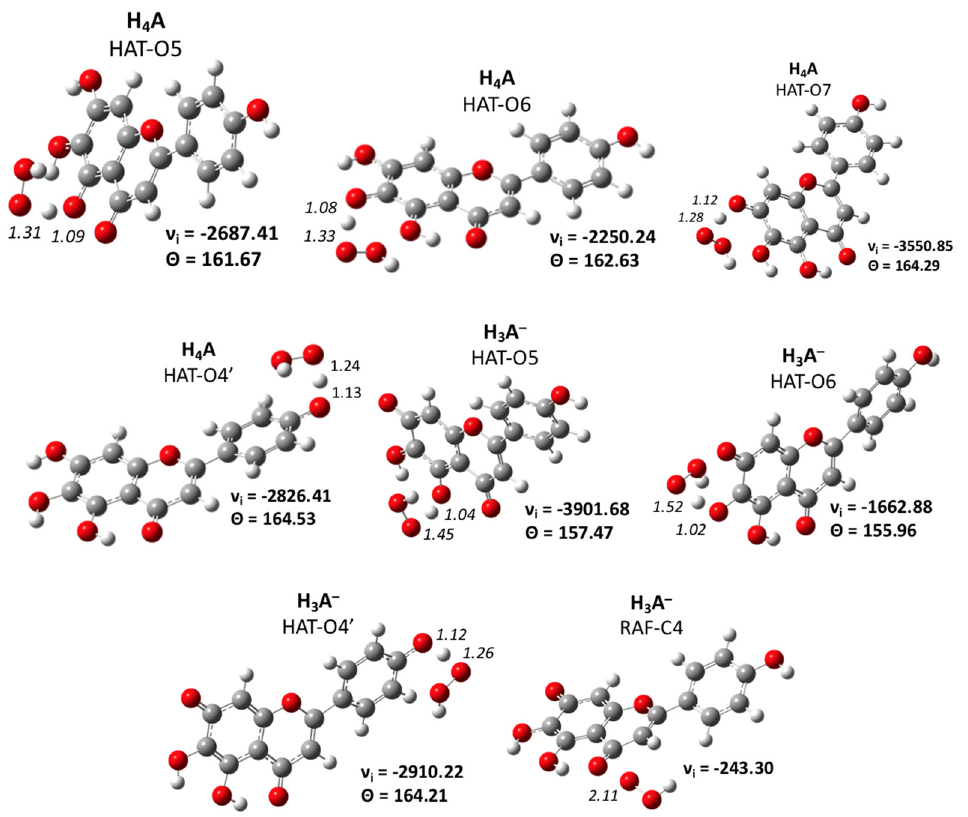
Figure 5. Optimized TS structures with the main geometrical parameters for the scutellarein in a water solvent. Bond lengths are in Å, angles ( Θ ) in degrees and imaginary frequencies ( ν ) in cm − 1